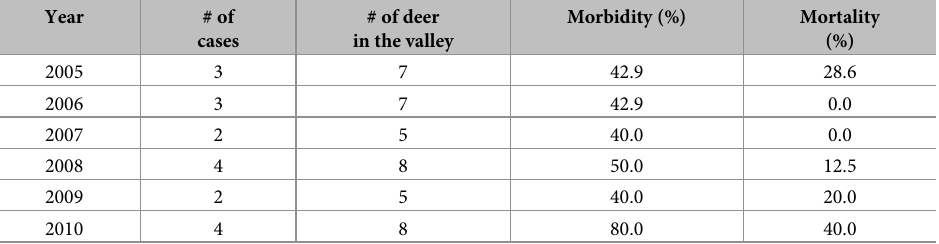
Regarding the distribution of lesions, one limb was affected in nine individuals (50%), two limbs in two (11%), and two fawns had either three or four limbs compromised (5.5% in each category). The number of affected limbs was undetermined in the remaining five animals (28%) (Table 2). The outcome of lesions varied. Seven individuals (38.9%) progressed to full recovery, six (33.3%) were found dead within a month of lesion detection (three females and three males), and the outcome was unknown in the remaining five deer (27.8%) because they could not be tracked. Most of the affected individuals in HV were observed during the fall (8 of 16 for which month was recorded), two and five affected deer were observed in the winter and spring, respectively, and only one case was observed in the summer. Cases were not seen in the remote BV or KV until 2008. Between 2008 and 2010, five adult males (infection rate = 1/18 in 2008 and 4/9 in 2010, all in BV) and a single adult female (1/12 in 2010, only case in KV), were observed with lesions in these valleys. Five of the six deer with foot lesions in KV and BV were recorded in the fall; the remaining one (2008 male) was reported during the spring. Table 3. Morbidity and mortality rates attributed to foot disease in huemul deer observed in Huemules Valley